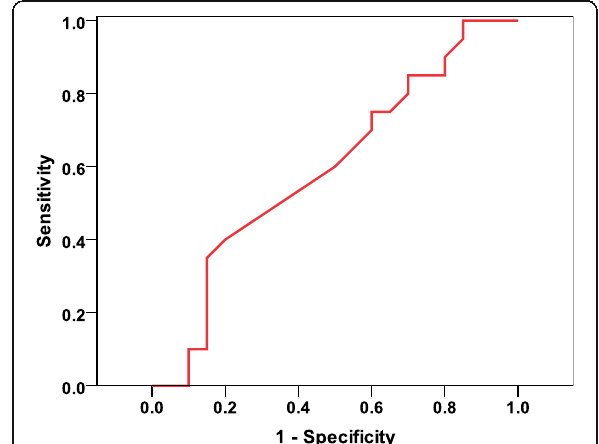
Fig. 2 ROC curve for vitamin D in differentiating MDD group from schizophrenia